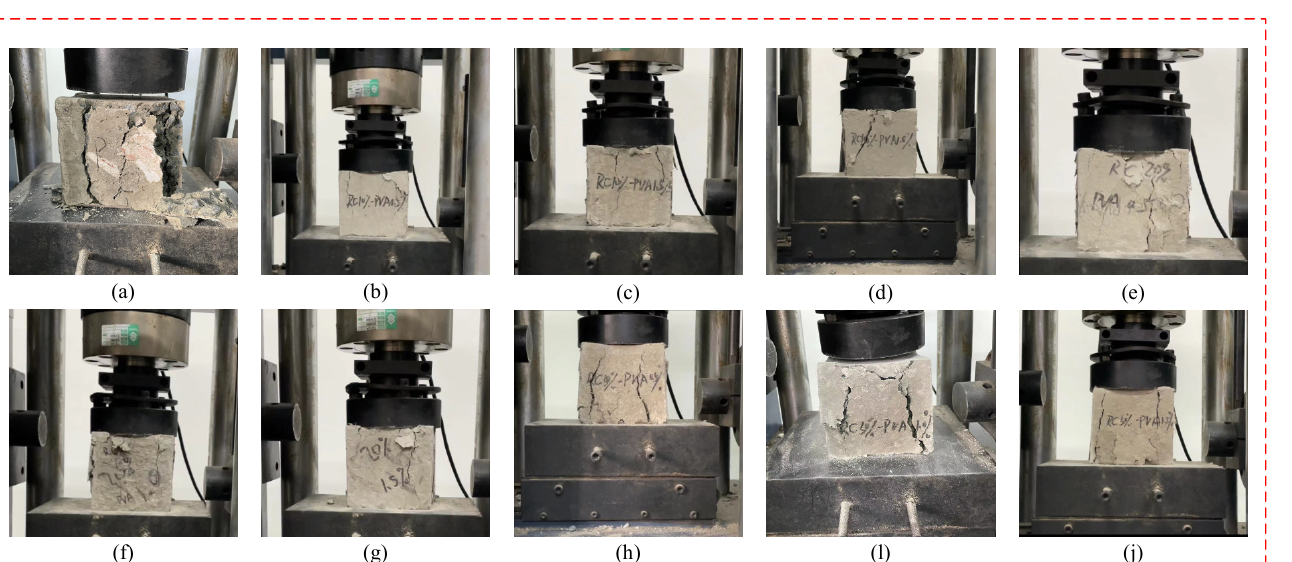
Figure 7. Compressive strength of specimens with different material substitution rates.